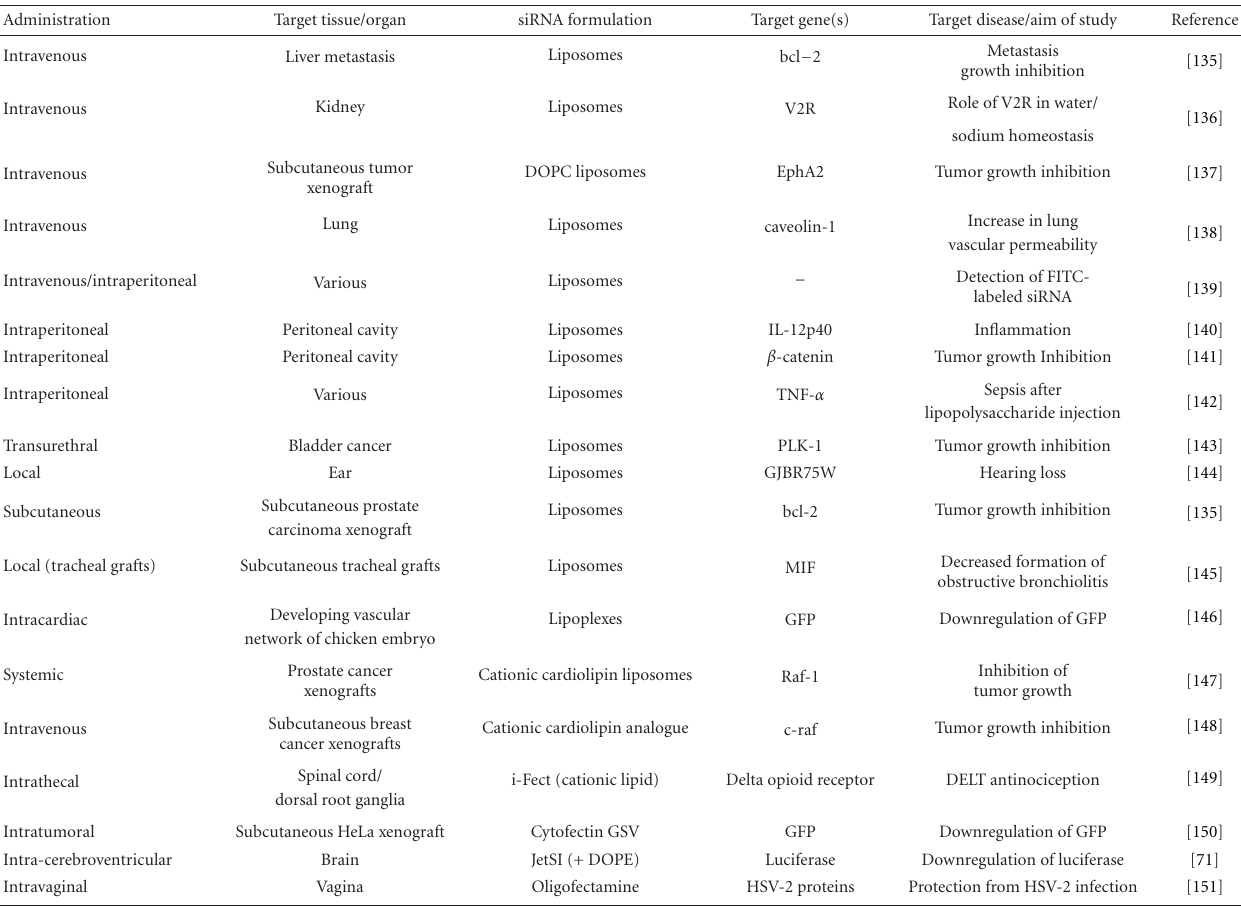
Table 2: Studies based on the direct application of siRNAs to induce RNAi in vivo: administration of siRNAs based on liposomes/cationic